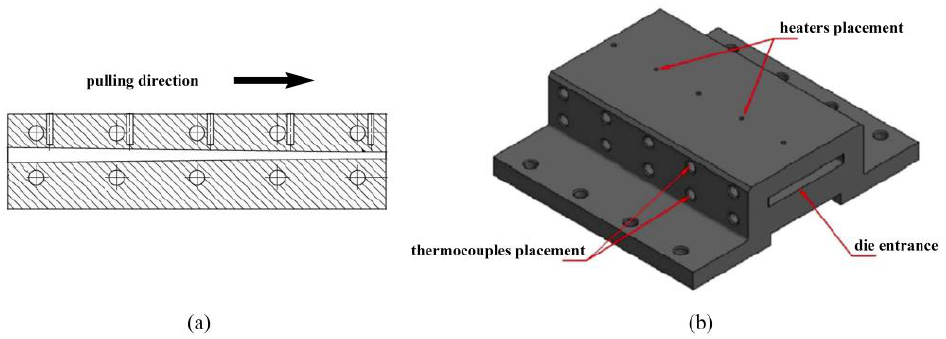
Figure 2. Diagram of the heated die block used to manufacture pultruded thermoplastic flat laminates of 75 mm × 3.5 mm: ( a ) cross section of the heated die block; ( b ) 3D model of the heated die